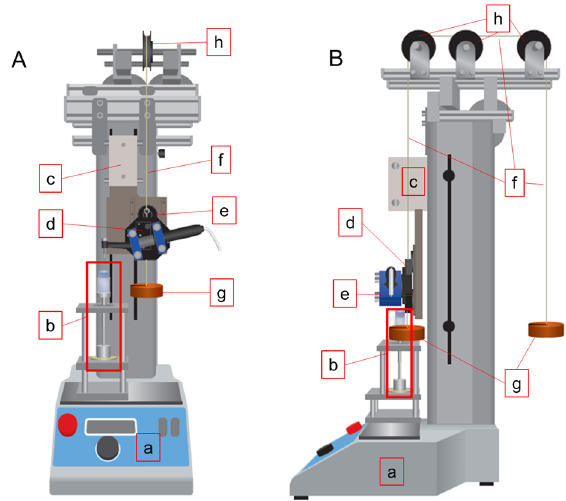
Figure 1. Schematics of the downward load-controlled root canal instrumentation device. ( A ) front view; ( B ) side view. a, motor-driven testing stand; b, torque/force measuring unit; c, mobile stage; d, handpiece holder; e, electromagnet; f, wire; g, weight; h, pulley.